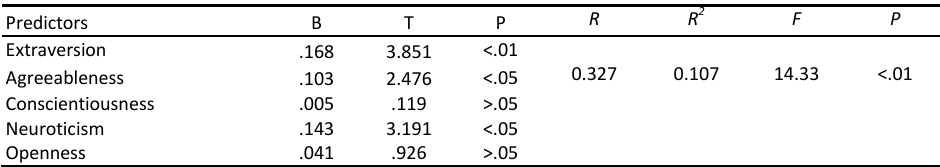
Table 3: Summary of Multiple Regressions showing the independent and joint prediction of extraversion, agreeableness, conscientiousness, neuroticism and openness on littering